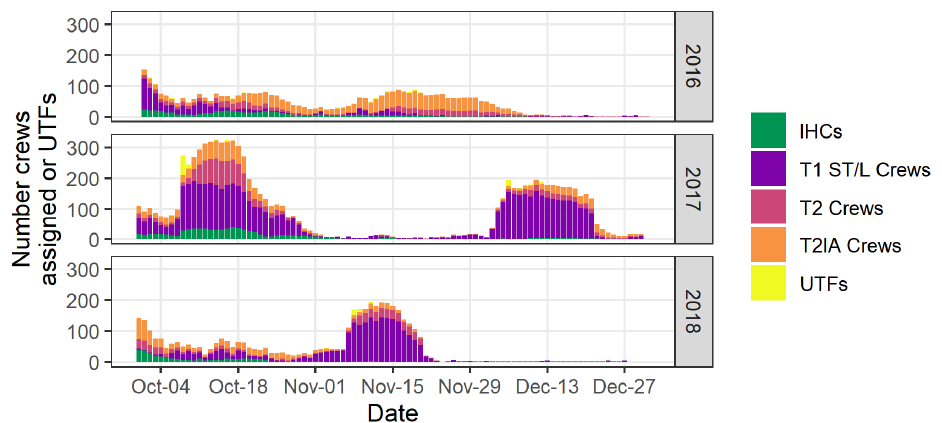
Figure 5. The daily number of Interagency Hotshot Crews (ICSs), Type 1 State and Local (T1 ST/L) Crews, Type 2 (T2) Crews, and Type 2IA (T2IA) Crews assigned to wildland fires, as well as requests for crews that were returned as “Unable to fill” (UTF) in the United States between 1 October and 31 December in 2016, 2017, and 2018.